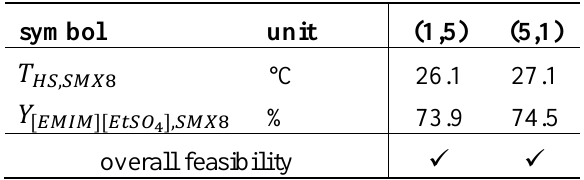
Table 9. Results for SMX8 after reactor simulation.